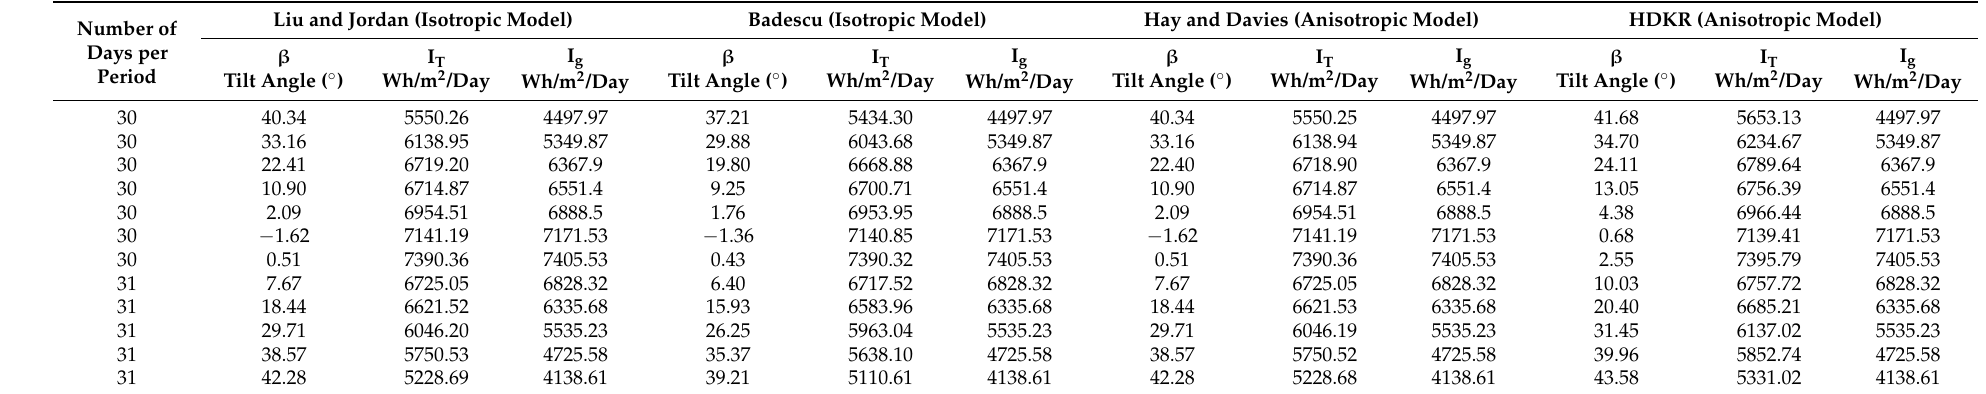
Table 6. Optimal tilt angles and solar radiation results for Makkah city.